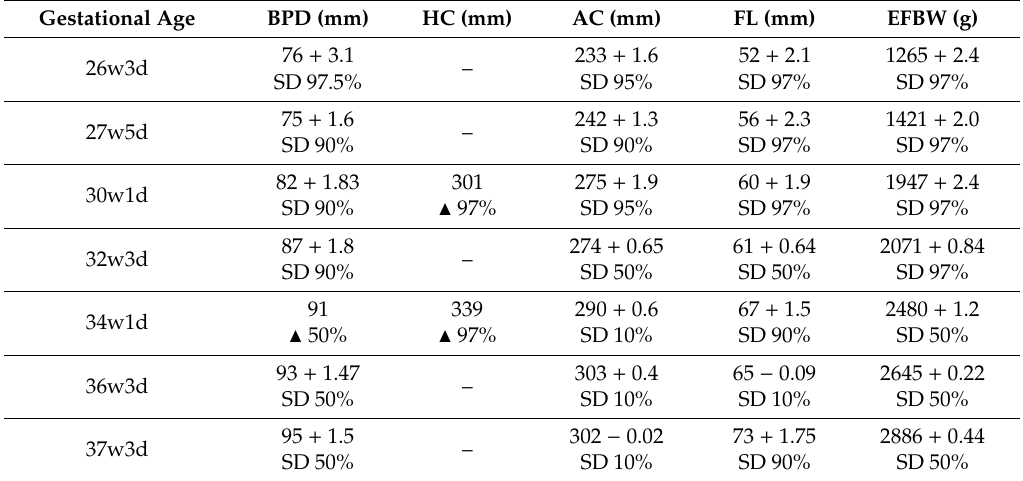
Figure 1. Overall changes in maternal body weight ( a ), abdominal circumference ( b ), and height of the uterus ( c ) before and after dietary modifications / intermittent fasting. Dietary modifications were implemented during the 26th week and intermittent fasting practice started at the 30th week and continued until the end of the pregnancy. Changes in fetal growth parameters following dietary modification, exercise, and intermittent fasting.